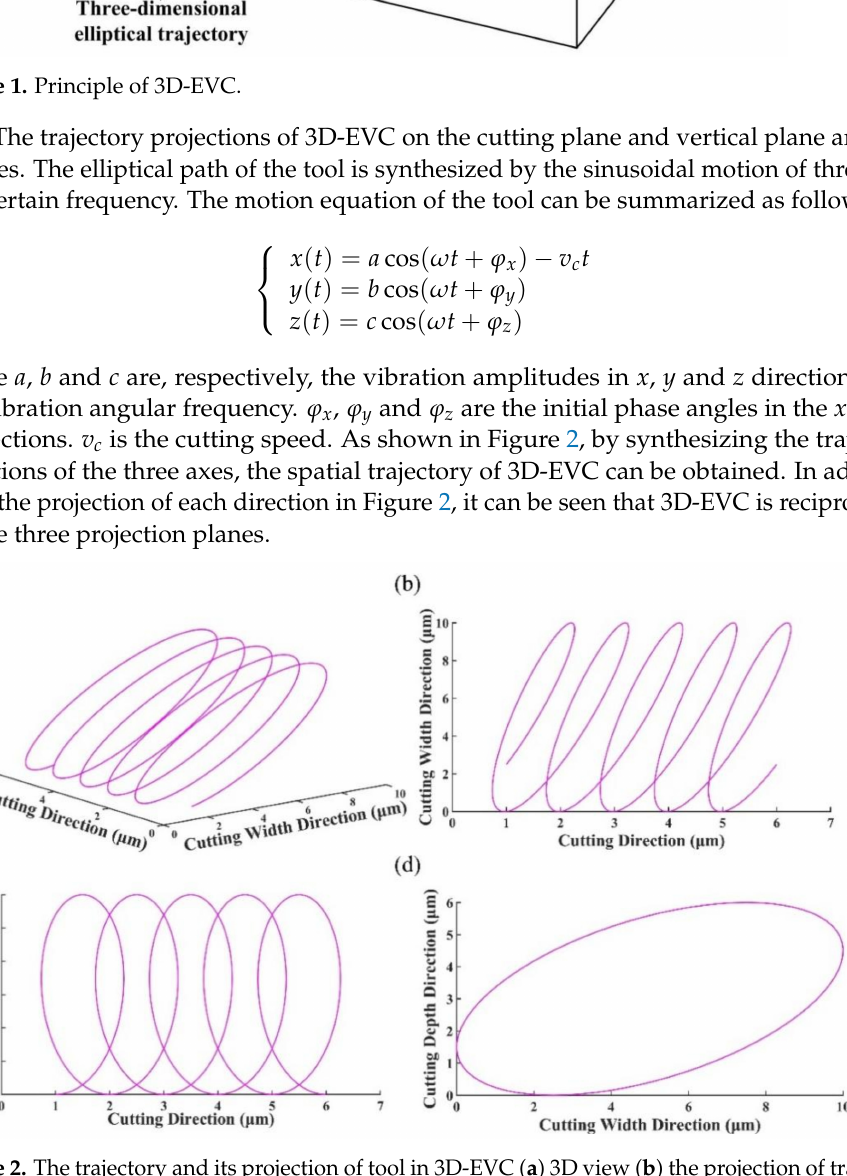
Figure 2. The trajectory and its projection of tool in 3D-EVC ( a ) 3D view ( b ) the projection of trajectory in XoZ plane ( c ) the projection of trajectory in XoY plane ( d ) the projection of trajectory in YoZ